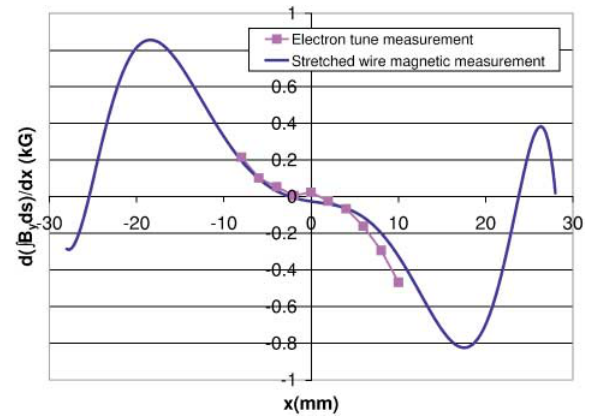
FIG. 6. (Color) Derivative of BL9 field integral for y (cid:1) 0